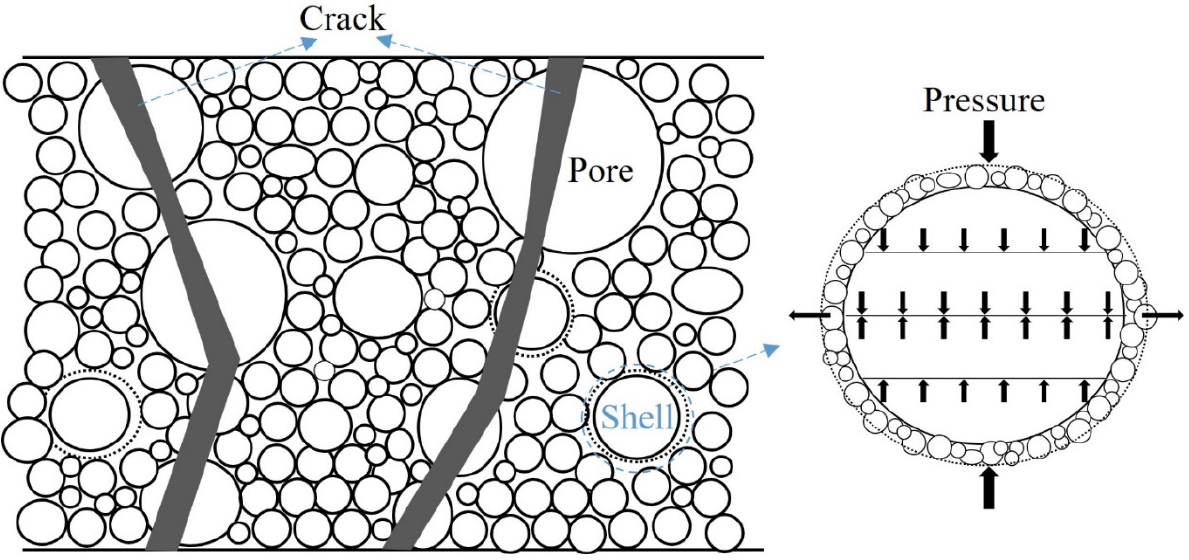
Figure 14. Microstructure of an FCPB sample.